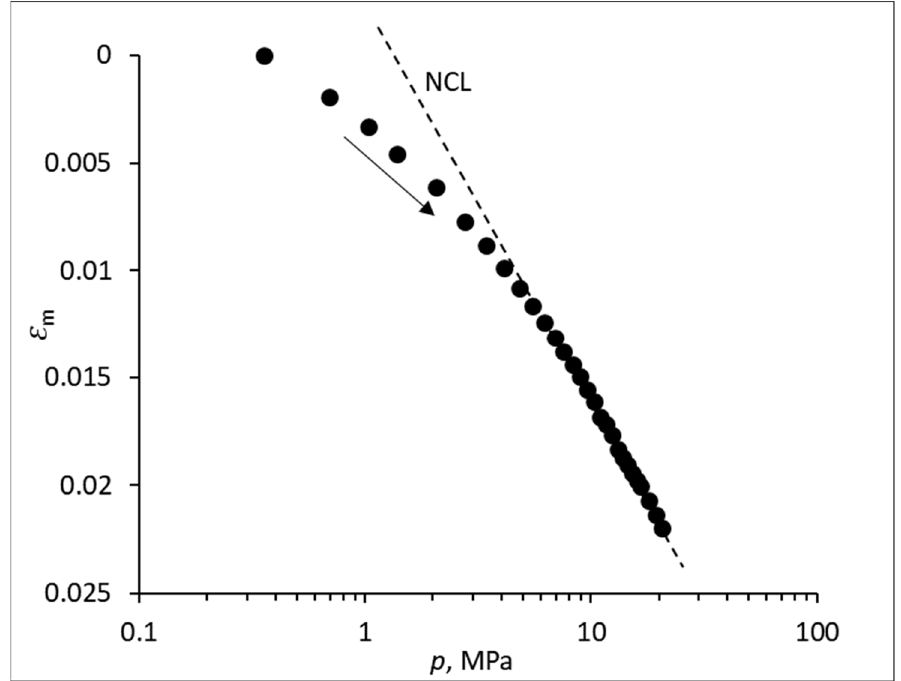
Figure 2. Strain–stress path of coal sample 1 under monotonic stress increase (up to 20.6 MPa or 3000 psi).